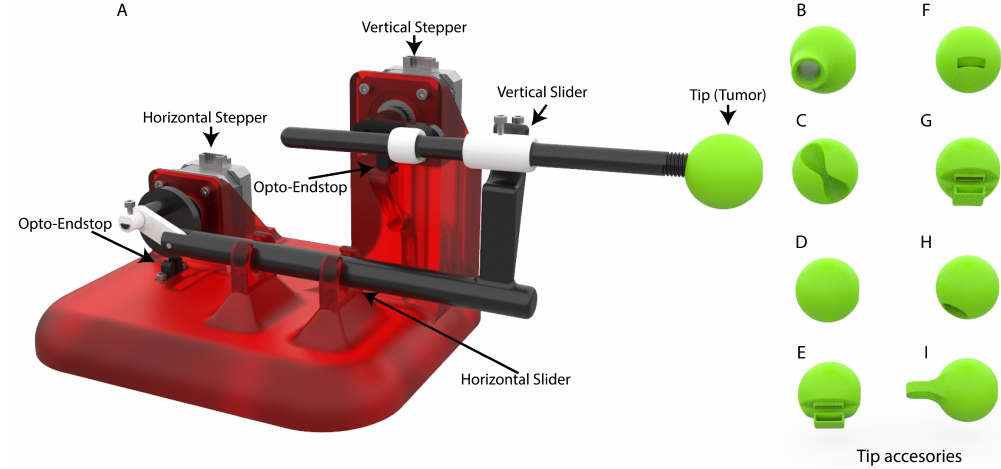
Figure 3. 3D model of the Lung Tumor Movement Simulator. Main design of the prototype A and eight tips model that were designed to give versatility to the model. Tips D – H were designed with the purpose of holding a nanoDot™radiation dosimeter. Tips B , C and I were designed to hold a test tube with contrast fluids for other